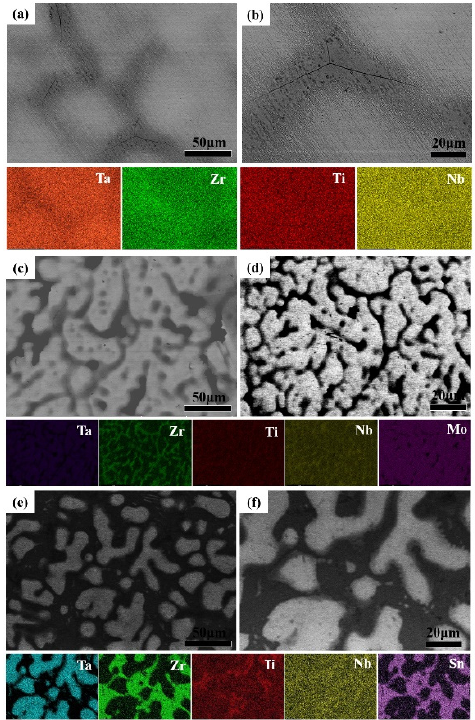
Figure 2. BSE images and corresponding EDS of high entropy alloys: ( a , b ) TiZrTaNb alloy; ( c , d ) TiZrTaNbMo alloy; ( e , f ) TiZrTaNbSn alloy.